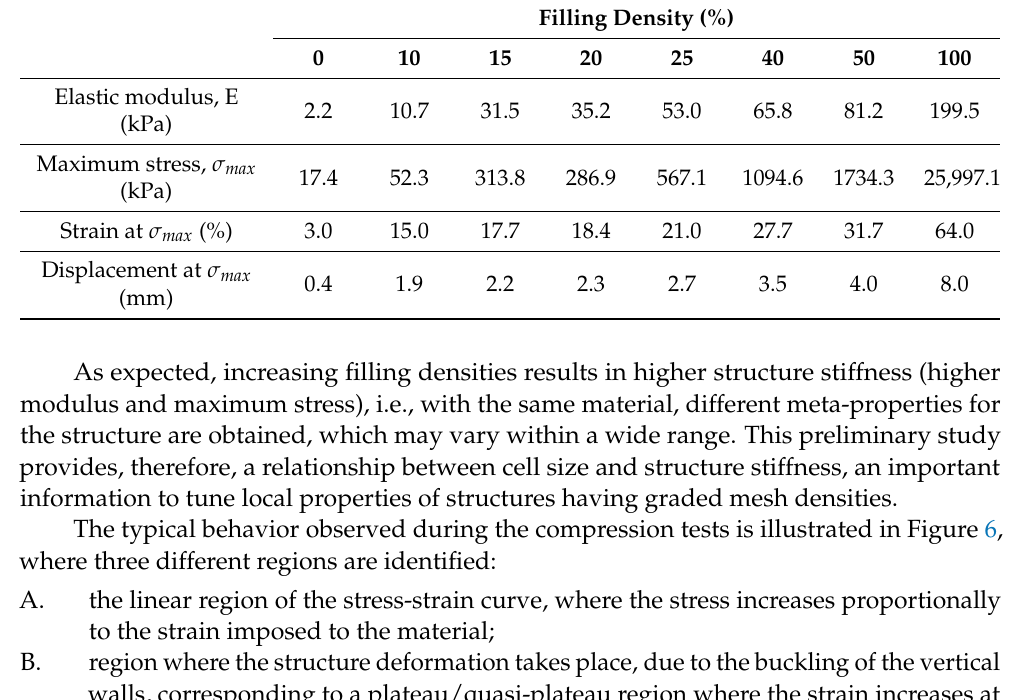
Figure 5. Stress—strain curves of the different types of samples tested in compression. (Note: the stress axe on the right should only be used for the 100% case). Table 1. Results of the compression tests.